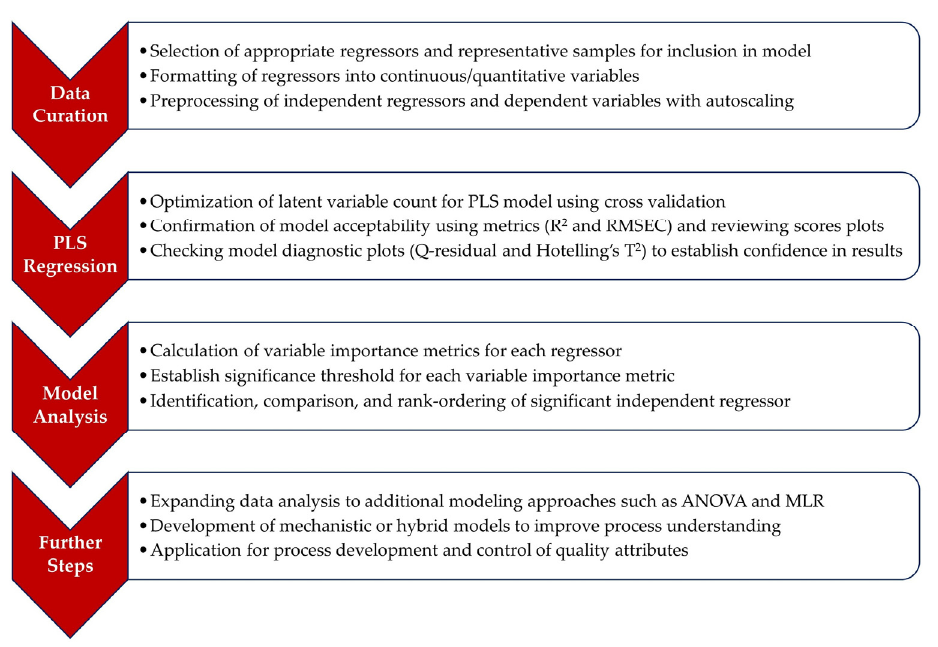
Figure 1. Summary of the proposed PLSR workflow for identifying the influential independent re- gressors.